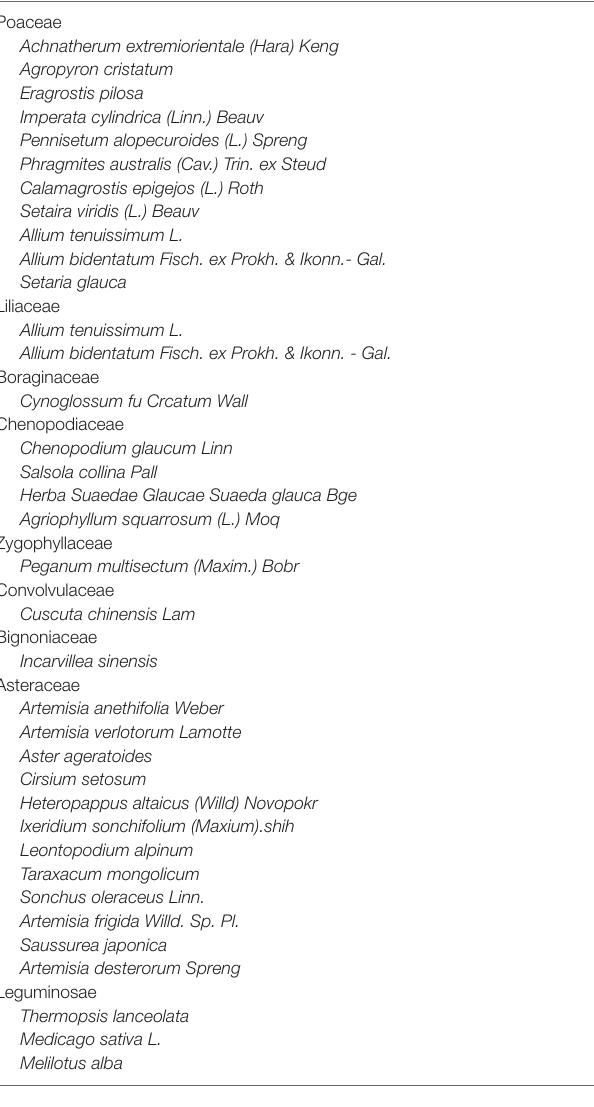
TABLE 1 | Modern plant species around Lake Hongjiannao.